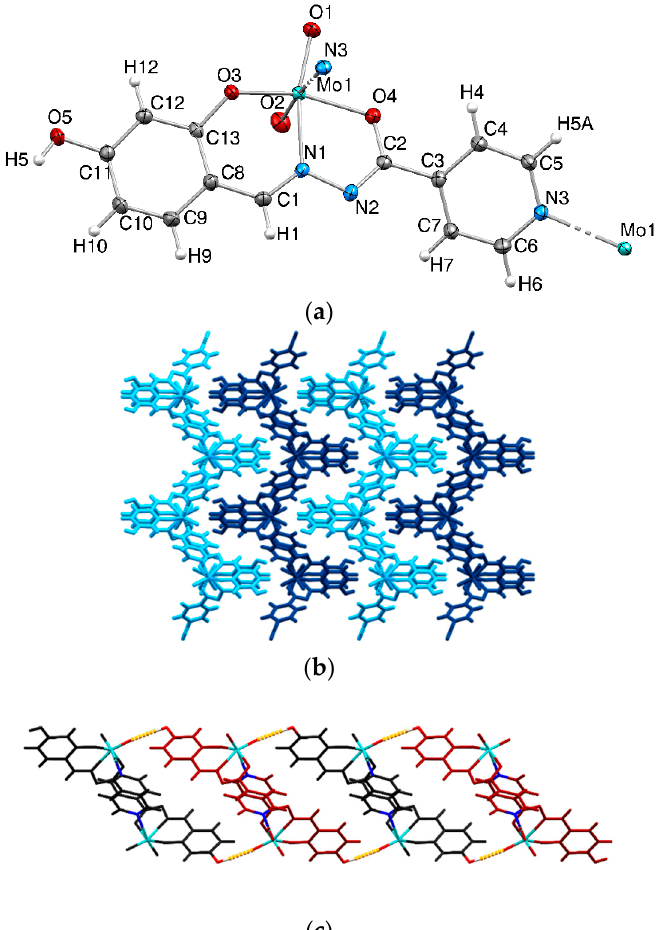
Figure 1. ( a ) ORTEP-PovRay plot of 3 ∙ H 2 O with the atom-labelling scheme (displacement ellipsoids of non-hydrogen atoms are drawn at the 50% probability level, H 2 O molecules are omitted for clarity). ( b ) Packing arrangement of the zigzag chains shown parallel to b -axis; ( c ) 1D chains are interconnected through hydrogen bonding interactions O5–H5 ∙∙∙ O1.